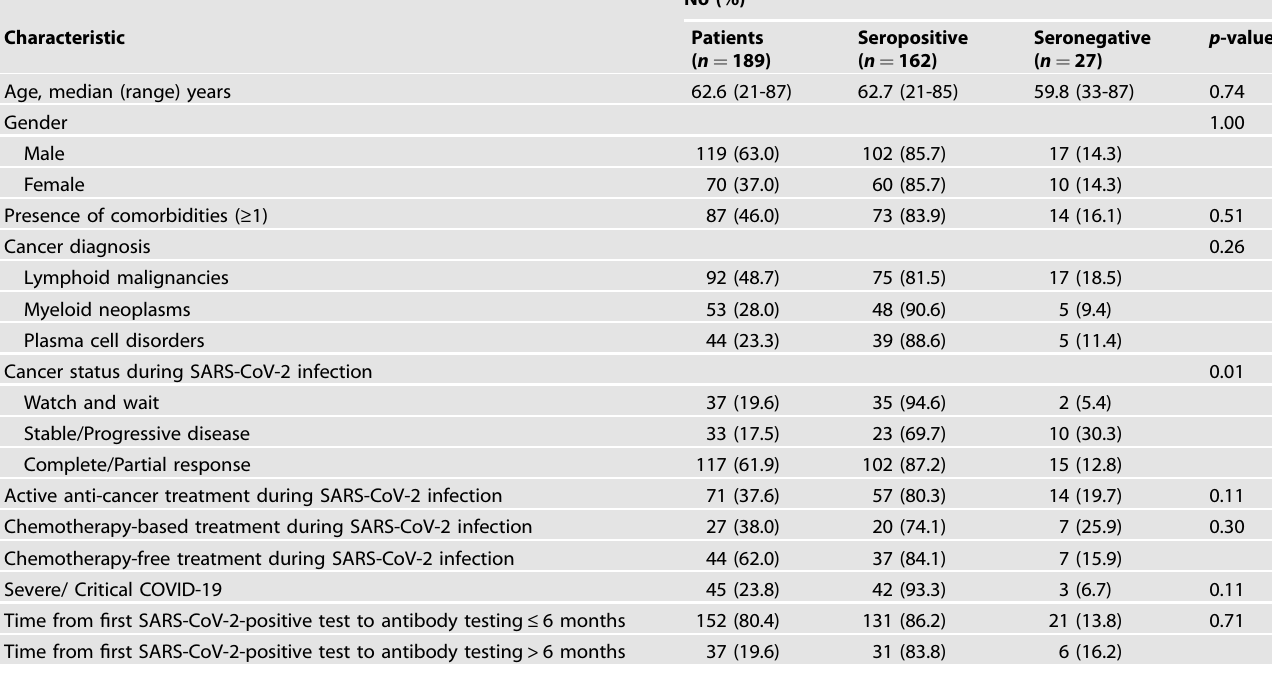
Table 1. Patients characteristics and anti-SARS-CoV-2 seroconversion